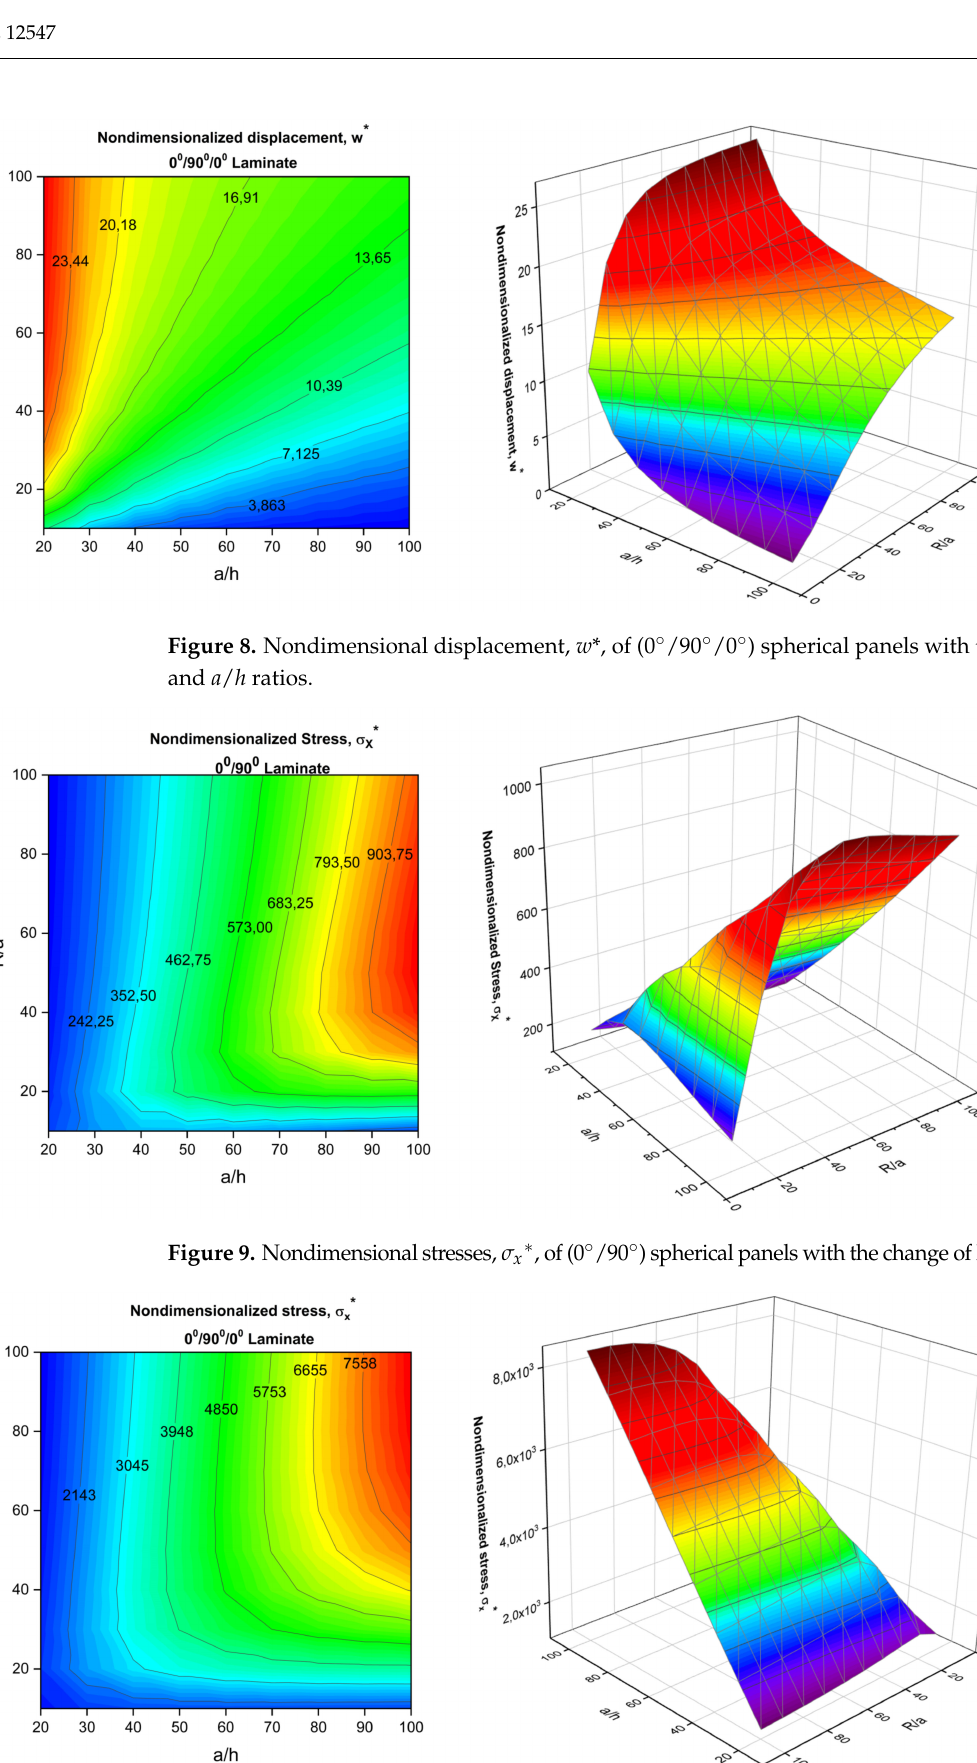
Figure 10. Nondimensionalstresses, σ x ∗ ,of(0 ◦ /90 ◦ /0 ◦ )sphericalpanelswiththechangeofR/ a and a / h